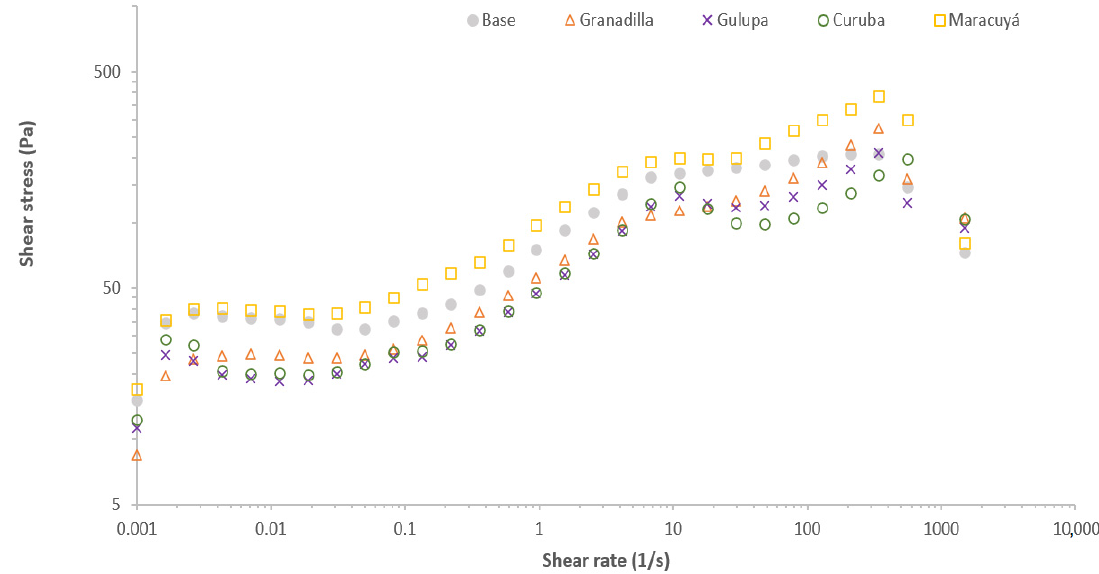
12 of 18 Figure 4. Viscosity profile of exfoliant prototypes. “Granadilla” ( Passiflora ligularis ), “gulupa” ( P. edulis Sims fo edulis ), “curuba” ( P. mollissima ), and “maracuyá” ( P. edulis , reference).